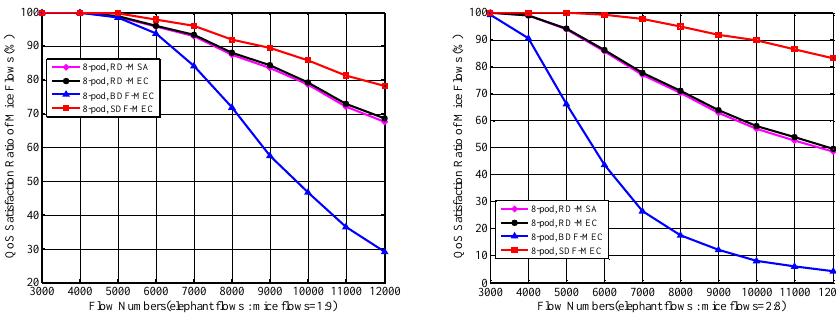
Figure 9. QoS satisfaction ratio of mice flows in 8-pod